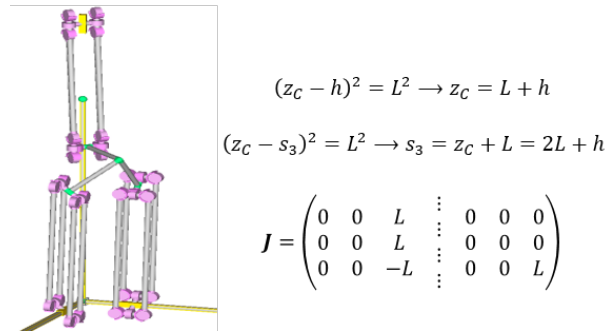
Figure 17. Increased mobility